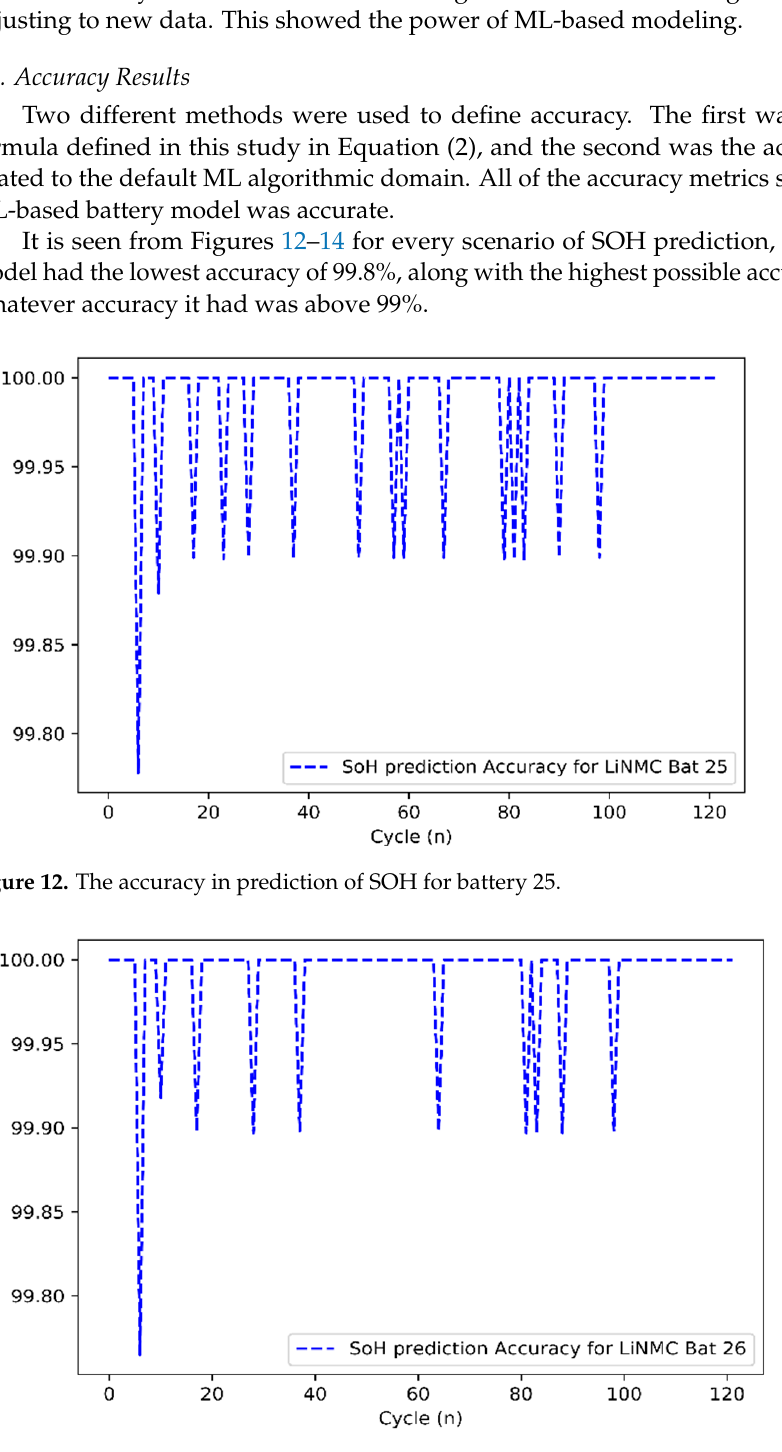
Figure 14. The accuracy in prediction of SOH for battery 27.